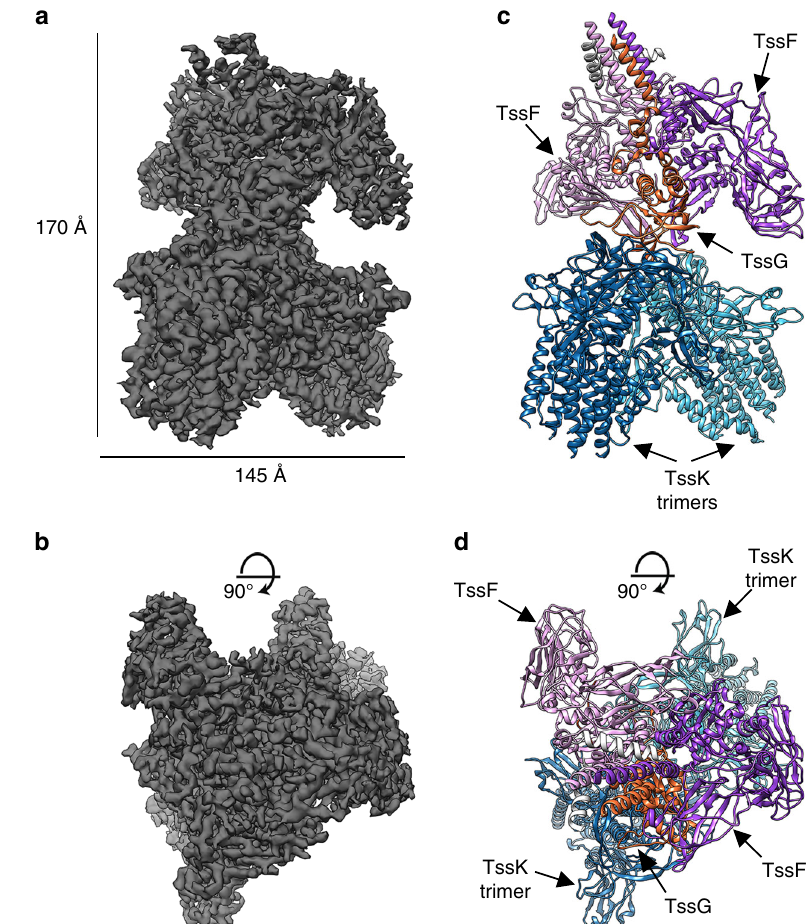
Fig. 3 CryoEM structure of the EAEC TssK SN – TssF – TssG complex. a , b Two orthogonal views of the reconstruction. c , d Ribbon diagrams of the atomic model in orientations corresponding to a , b . Each subunit is colored differently. TssK: dark and light blue, TssF: purple and pink, TssG: orange, and two short unassigned segments are colored light